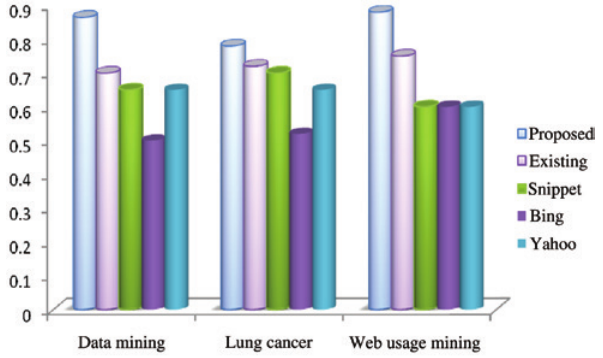
Figure 5: Precision Comparison for the User-Given Queries When Top 100 Links Are Taken.